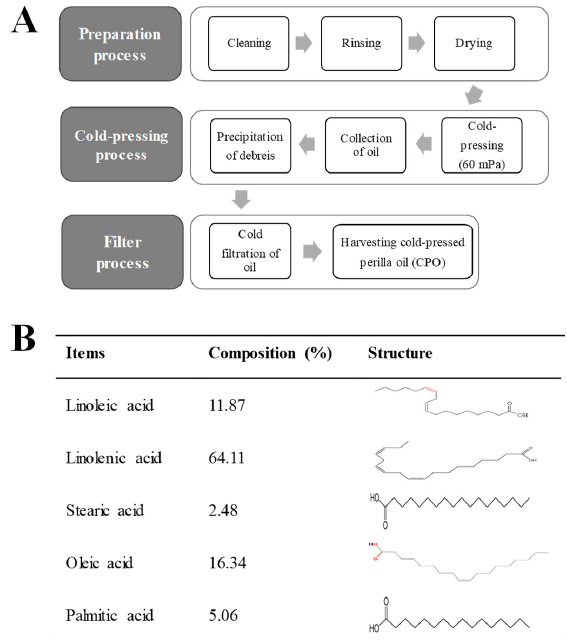
Figure 1. Preparation process and composition of CPO: ( A ) CPO was obtained from dried seeds of P. frutescens using a cold press at 60 Mpa and passing the crude oil through 6–8 µ m membrane filters; ( B ) GC-MS showed CPO contained five fatty acids, that is, linoleic acid, linolenic acid, stearic aicd, oleic acid and palmitic acid.